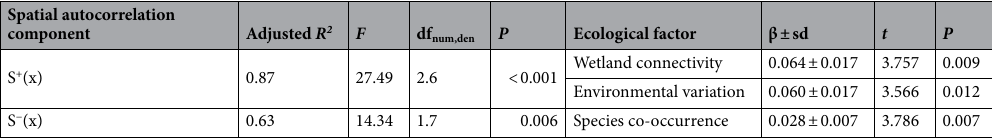
Table 3. Effects of ecological factors on autocorrelation levels of plant community parameters according to an exhaustive model selection approach based on the Akaike information criterion corrected for small sample size. Ecological factor effects were tested separately for the positive (S + (x)) and negative (S − (x)) spatial autocorrelation components of the community parameters. The models used the autocorrelation levels of each community parameter as the dependent variable and the PLS-SEM path coefficients measuring the direct effects of the ecological factors on each community characteristic as